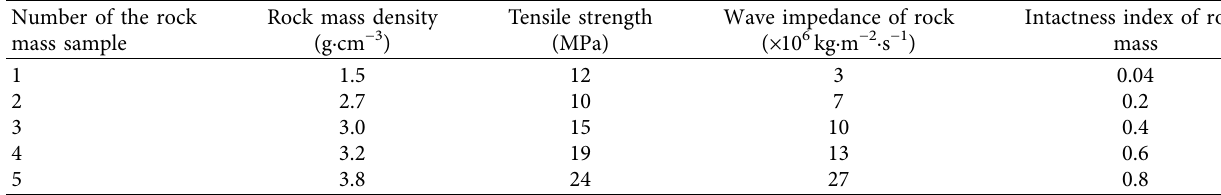
Table 5: Parameters of the sample rock